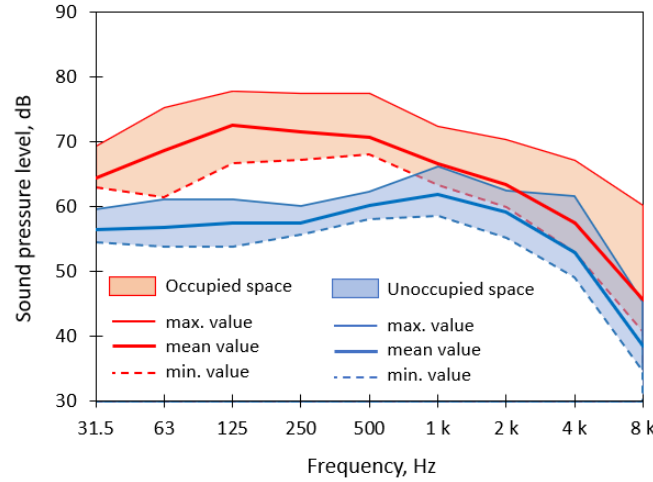
Figure 6. Average noise levels and the range of noise levels measured in the food court FC1 with (red) and without (blue) visitors.